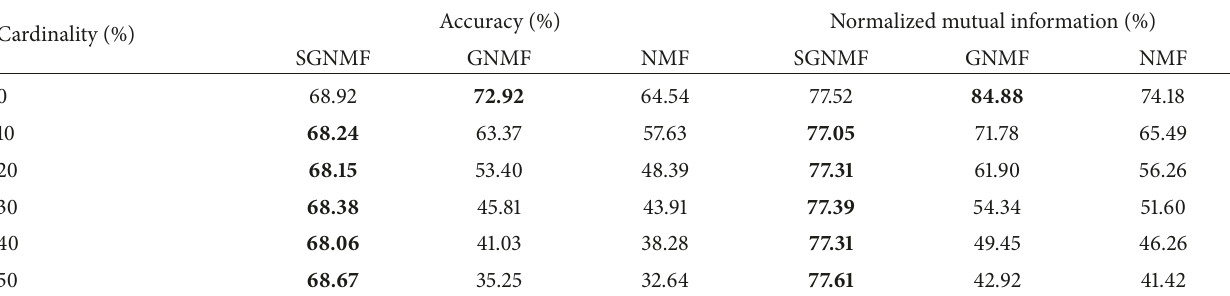
Table 9: Clustering performance on COIL20 in case 1 .